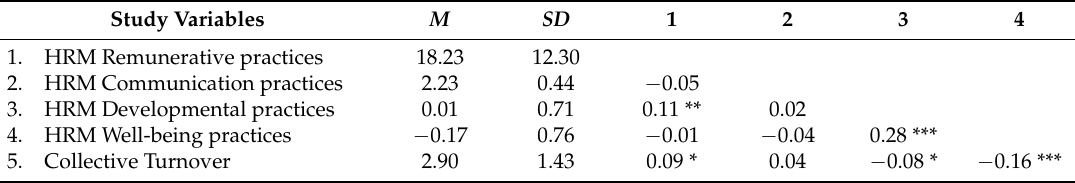
Table 2. Correlations between Study Variables at Company Level ( n =